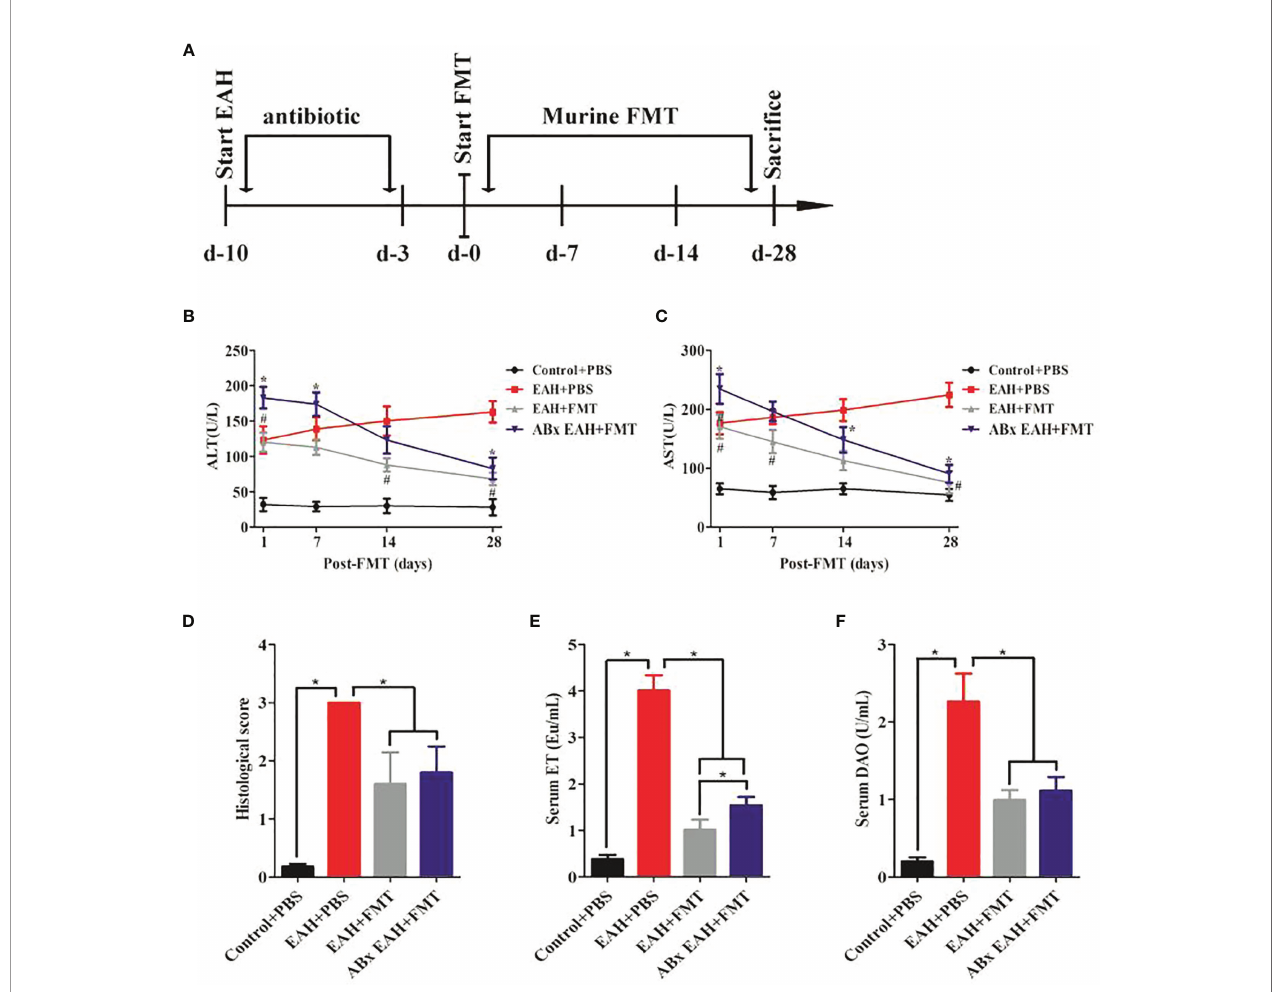
FIGURE 3 | FMT attenuated liver injury and bacterial translocation. (A) Experimental setup. Secondary EAH mice harboring dysbiosis (ABx) mice were generated by broad-spectrum antibiotic treatment for 7 days. Three days before FMT, the antibiotic cocktail was replaced by sterile tap water to guarantee antibiotic washout. ABx EAH mice were then subjected to FMT on 28 consecutive days; (B, C) serum ALT/AST levels; (D) histological score of liver lesions; (E) serum ET levels; (F) serum DAO levels. The horizontal lines indicate the mean values of the different groups. *p <